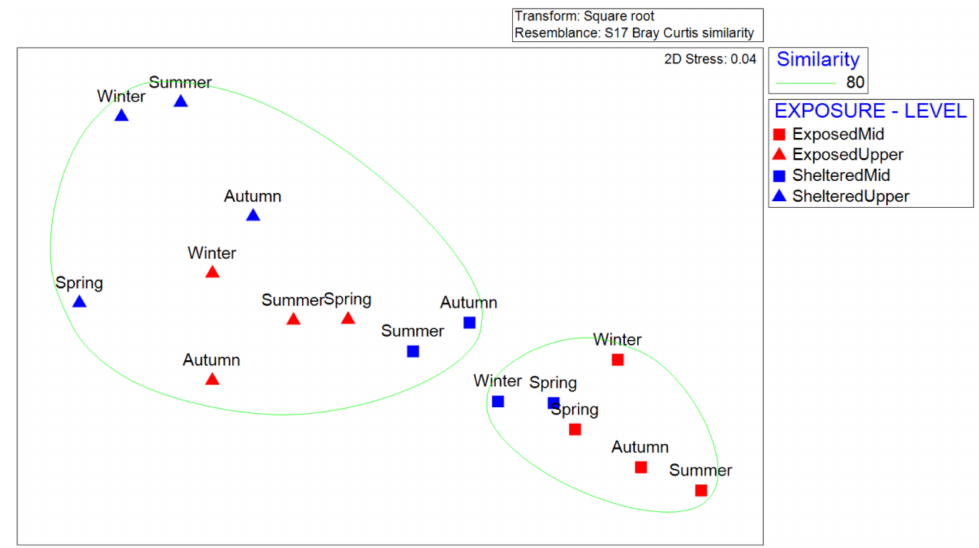
Figure 10. Multidimensional scaling ordination plot of the level of similarity of C. stellatus population cover among sampling sites, shore levels, and seasons, based on the Bray–Curtis similarity index of square root-transformed cover percentages. Closer points indicate higher similarity. The ellipses group mid and upper shore and have no statistical